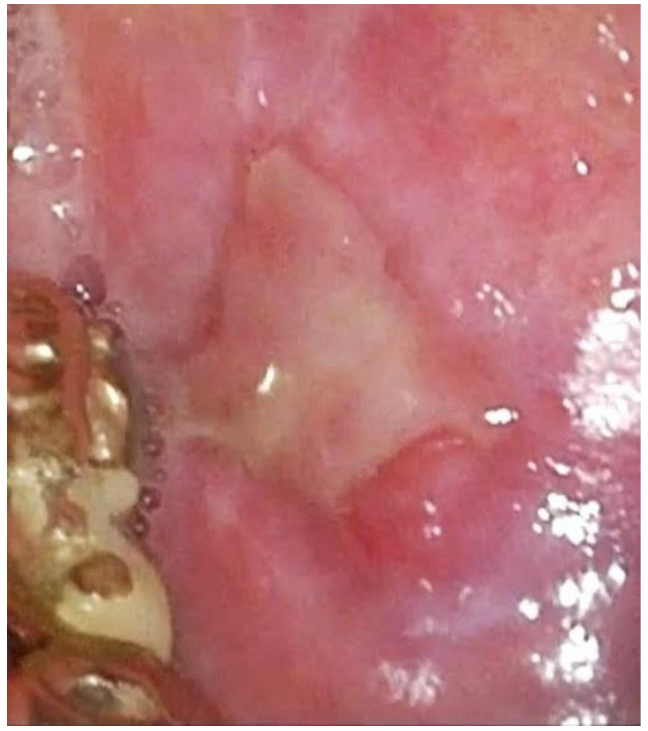
Figure 4. Ulcerated erythroplasic lesion in white light imaging.